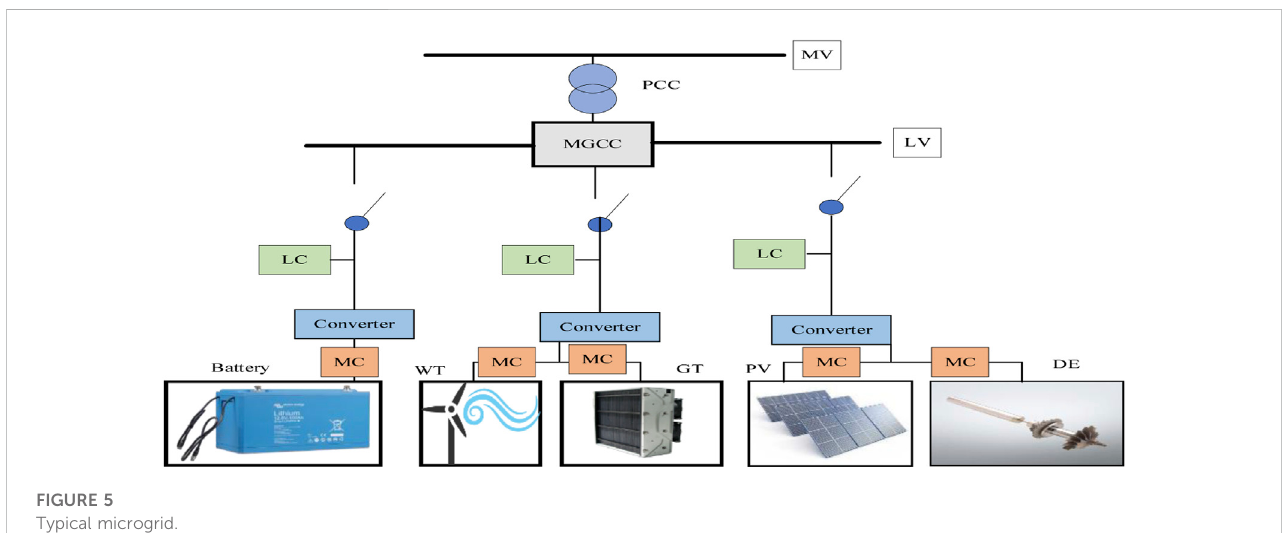
FIGURE 5 Typical